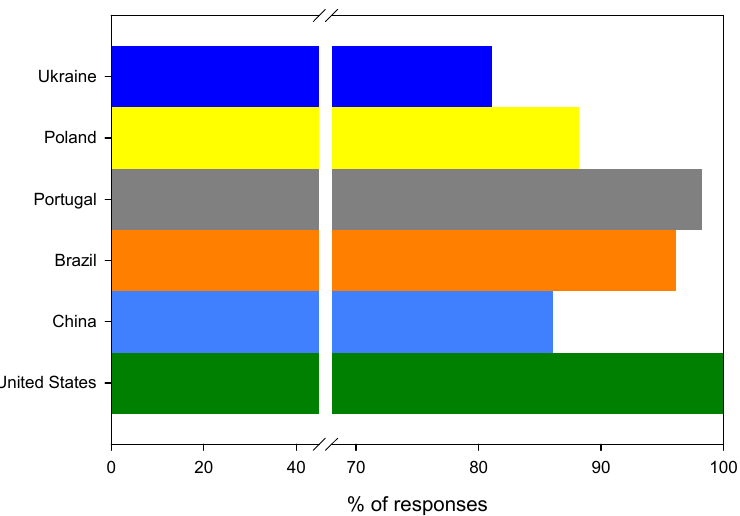
Figure 11. The distribution of positive answers to the question: Would you encourage others to use modern, environmentally friendly packaging?